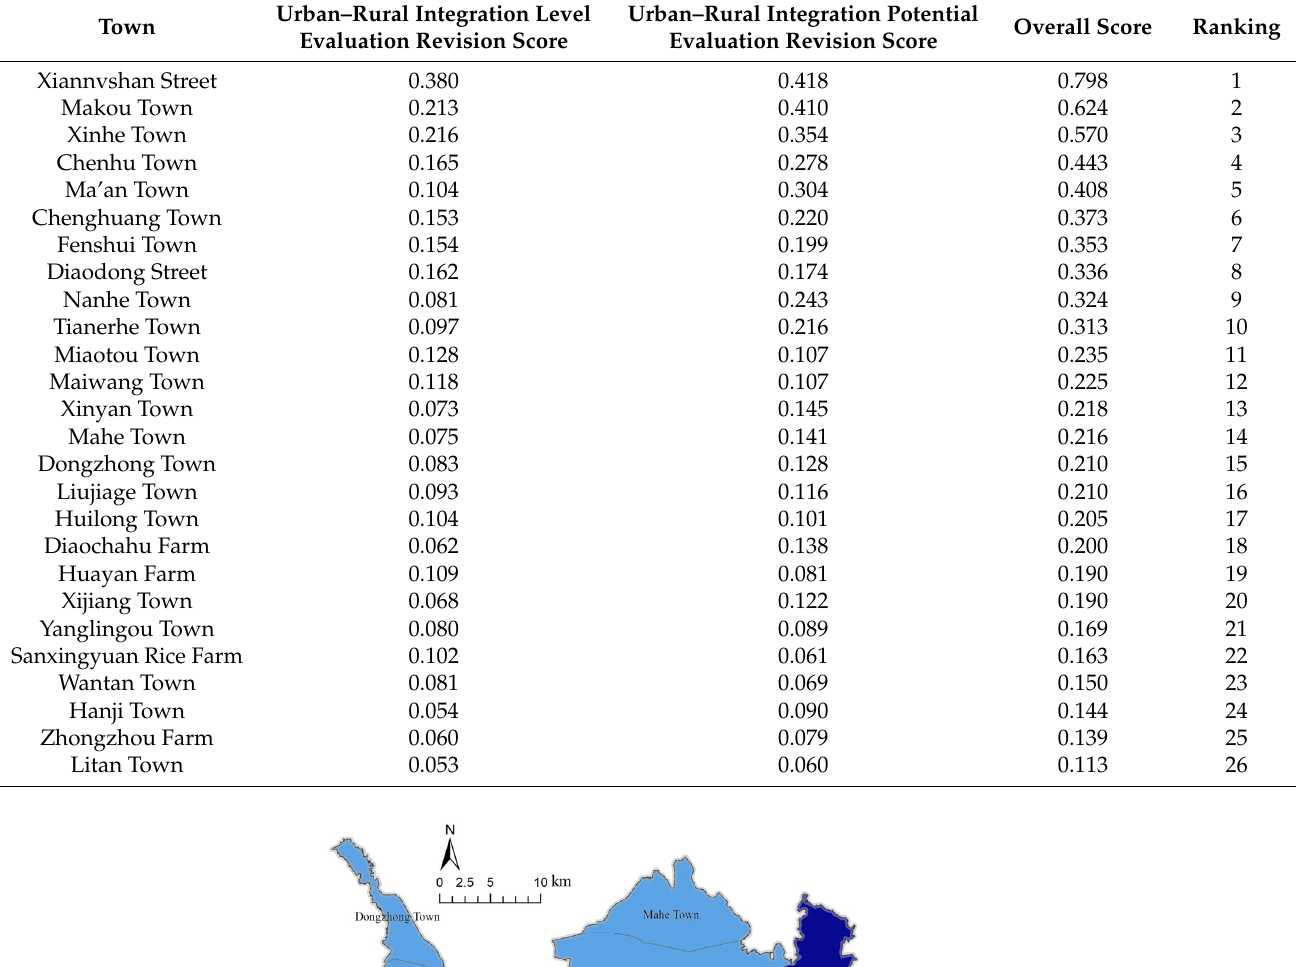
Table 3. Ranking of the comprehensive evaluation results of urban–rural integration development.